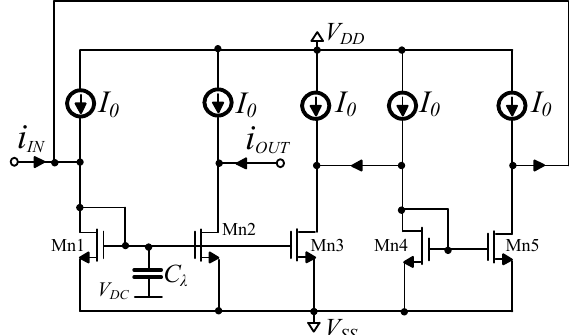
Figure 12. Fractional-order integrator using current mirrors.